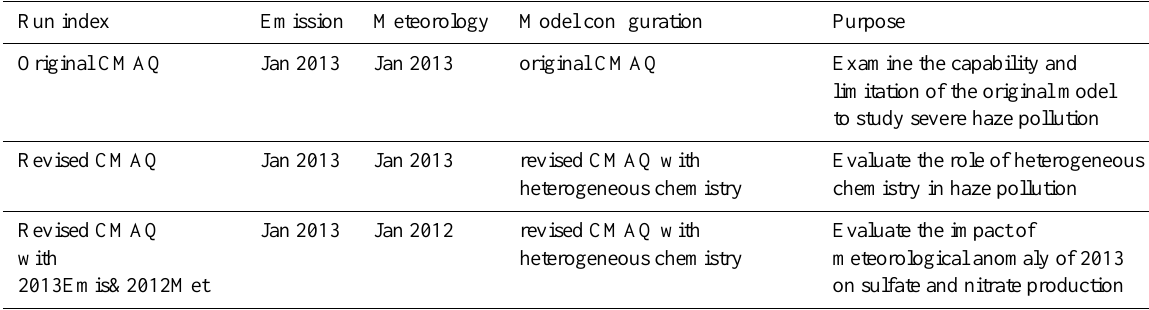
Table 4. Simulation